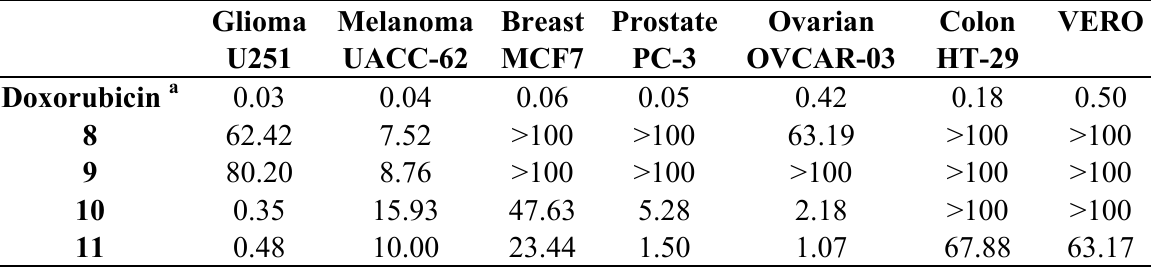
Table 1. IC values (in μ M) for compounds 8 – 11 50